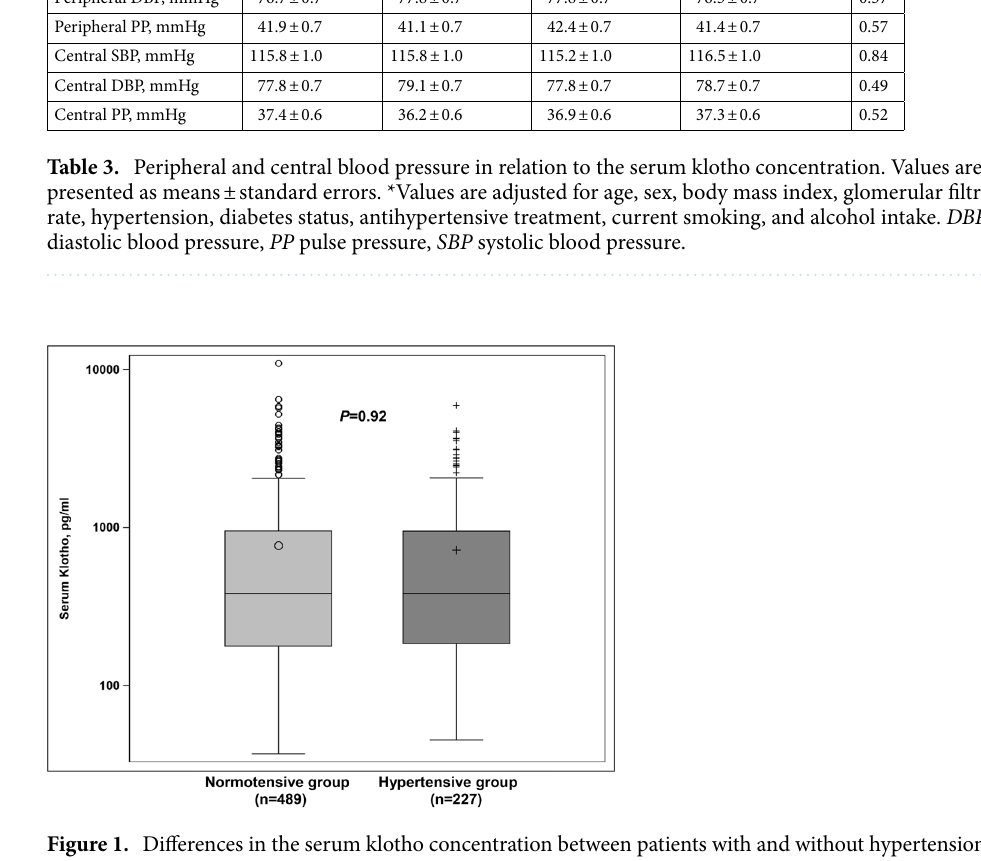
Figure 1. Differences in the serum klotho concentration between patients with and without hypertension.